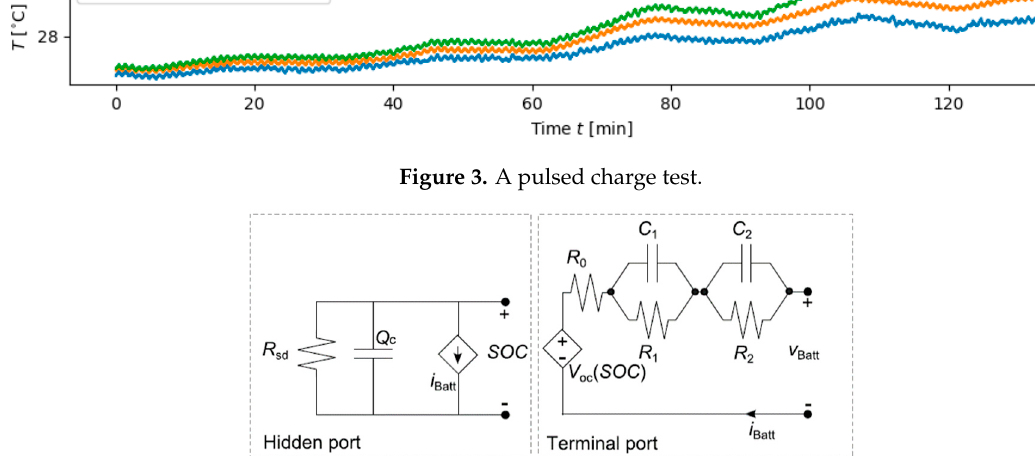
Figure 3. A pulsed charge test.